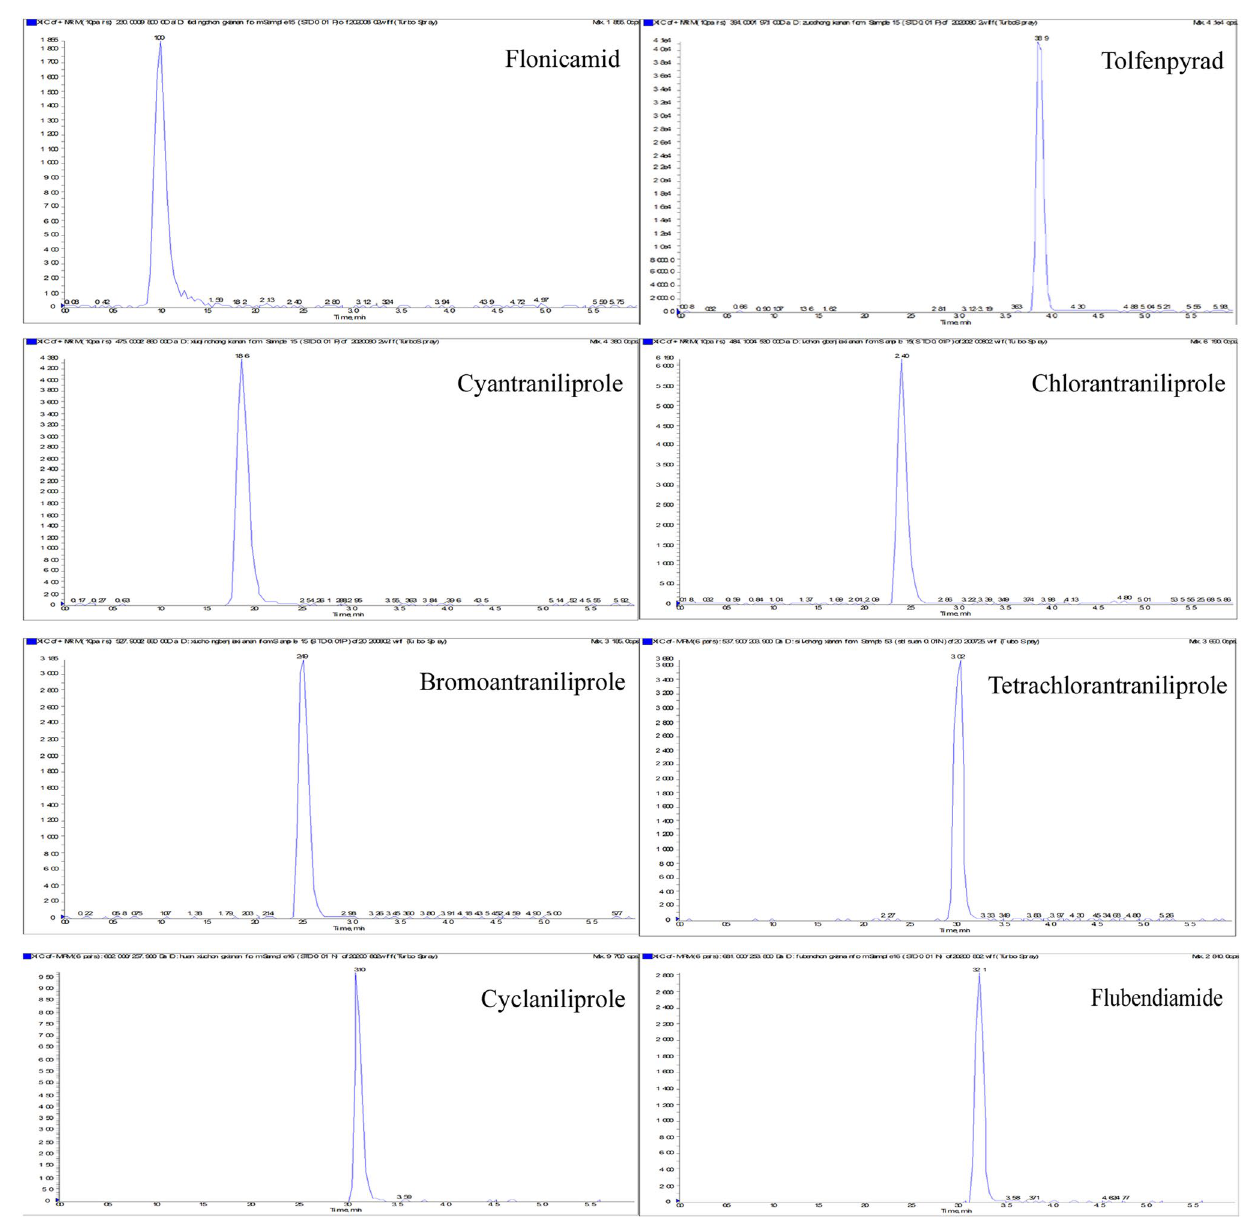
Figure 4. Chromatograms of amide